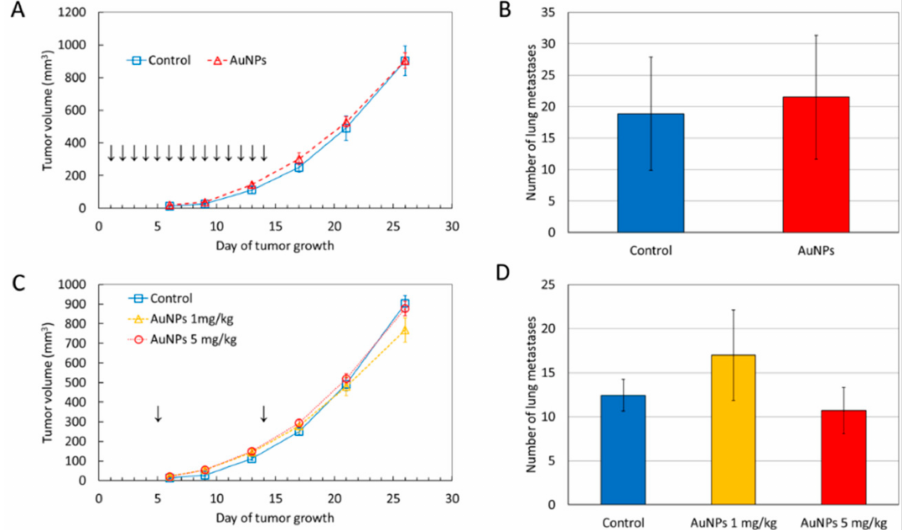
Figure 1. Tumor volume and the number of lung metastases in mice treated with gold nanoparticles (AuNPs) intragastrically ( A , B ) and intravenously ( C , D ). Arrows indicate the day of AuNP admin- istration. Data are presented as the mean ± standard error from 6 mice. The differences are not statistically